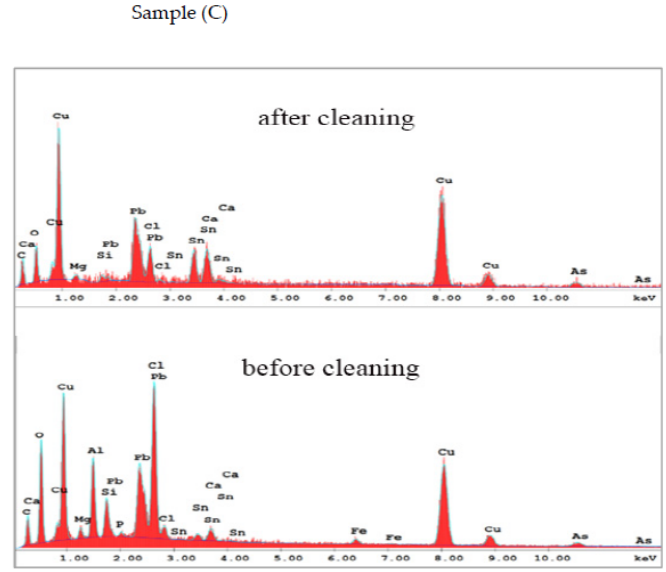
Coatings 2022 , 12 , x FOR PEER REVIEW Figure 15. The EDX analysis of the coin (C) before and after laser cleaning. Figure 15. The EDX analysis of the coin (C) before and after laser cleaning.